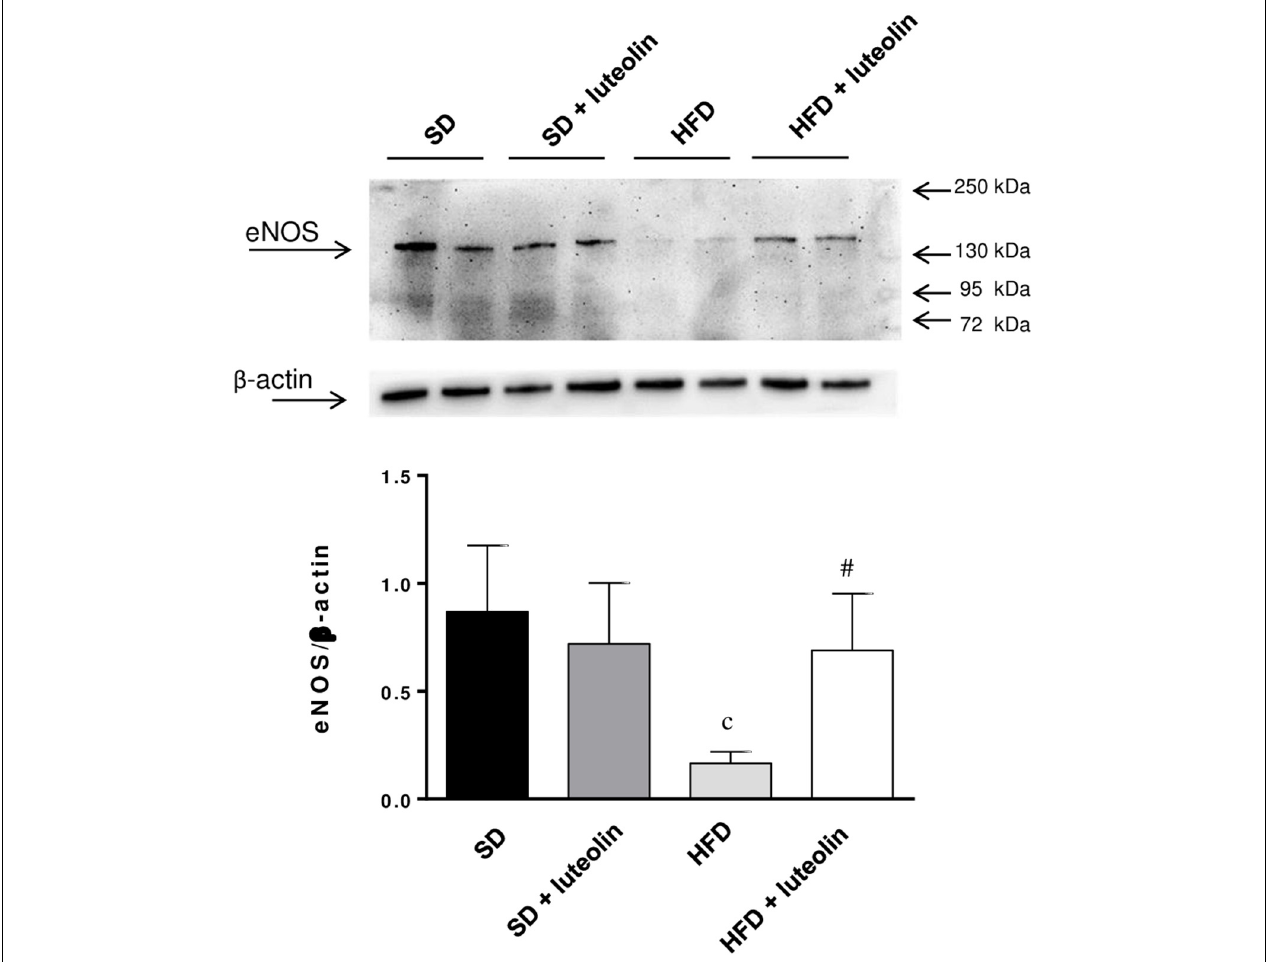
FIGURE 7 | Western blot analysis of eNOS expression in mesenteric arteries from mice fed with SD, SD plus treatment with luteolin (10 mg/Kg/day), HFD or HFD plus treatment with luteolin (10 mg/Kg/day) for 8 weeks. The figure displays representative blots and column graph referring to the densitometric analysis of immunoreactive bands of eNOS normalized to the expression of β -actin. Each column represents the mean ± SEM of five animals. c P < 0.001, significant difference vs. SD; # P < 0.001 significant difference vs. HFD. Statistics: two-way analysis of variance followed by Newman–Keuls